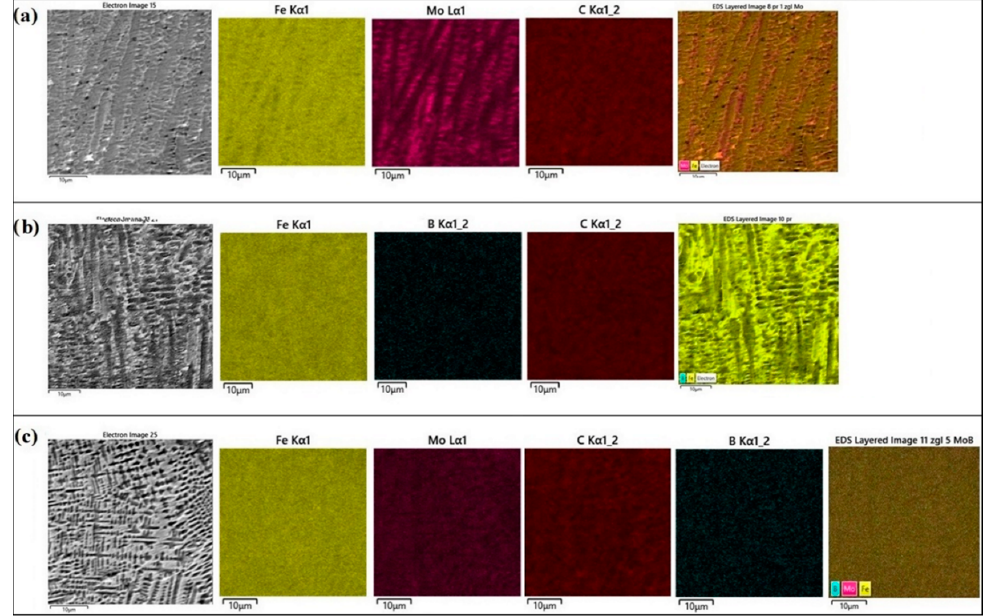
Figure 5. EDS mapping of produced: ( a ) Mo coating, ( b ) B coating, ( c ) Mo-B coating.